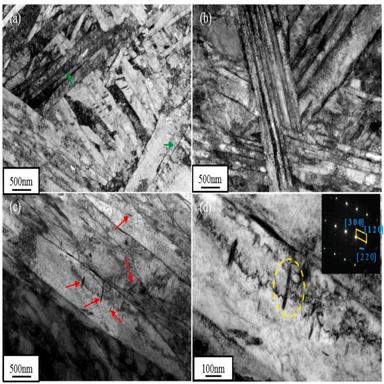
TEM images of Ni-advanced steels prepared by different processes (a) TMCP steel, (b) DQ steel, (c) QT steel, (d) precipitates in QT steel.